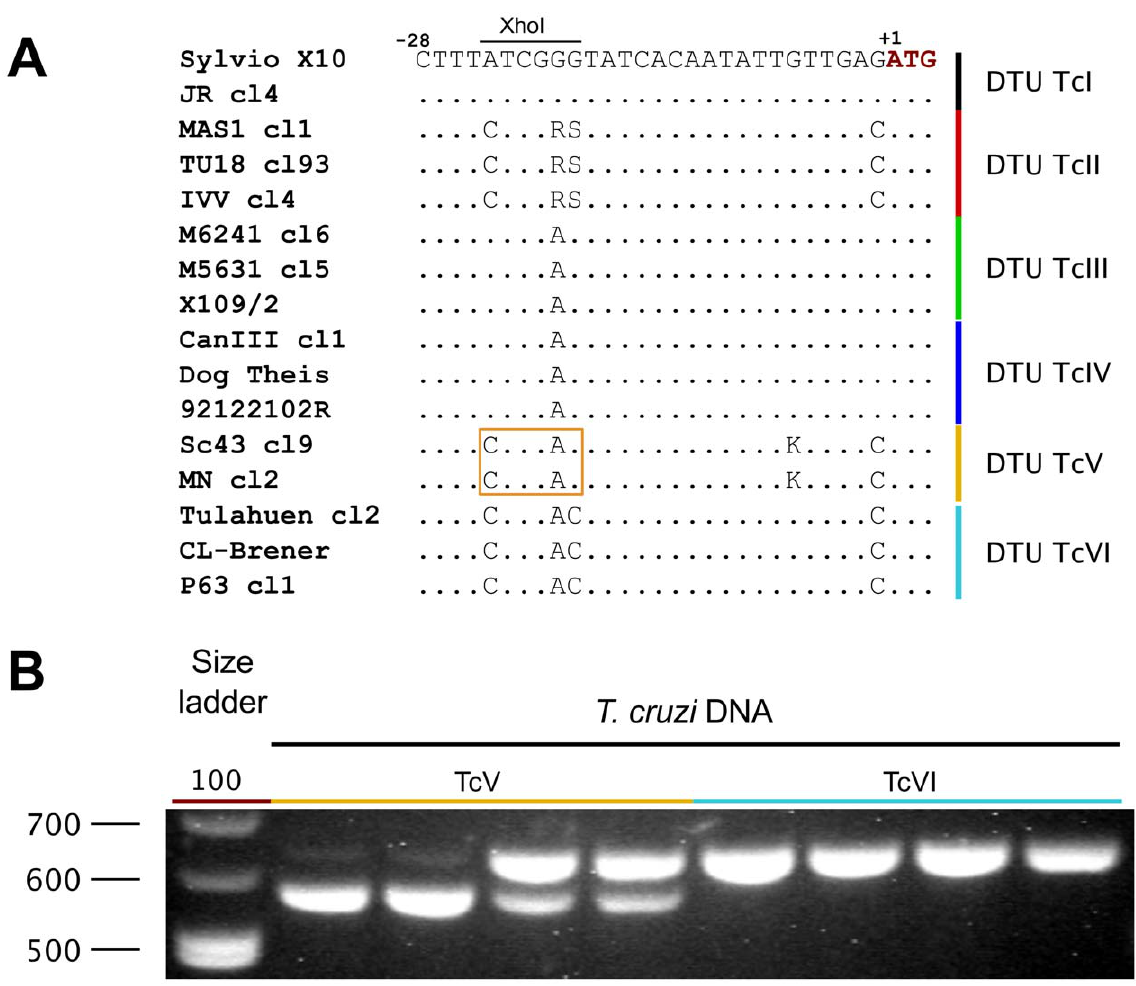
Figure 3. Restriction fragment length polymorphism analysis of the TcMK amplification product. A: a multiple sequence alignment of the 5 9 -UTR just upstream of the translational start codon, showing the polymorphic Xho I site. A solid line box marks the Xho I site in TcV strains. B: Agarose gel electrophoresis showing a PCR-RFLP analysis of selected strains. Strains analyzed were: Sc43 cl9, MN cl2, LL014 and Teh53 for DTU TcV; and Tulahuen cl2, CL-Brener, Tul2 and P63 cl1 for DTU TcVI.